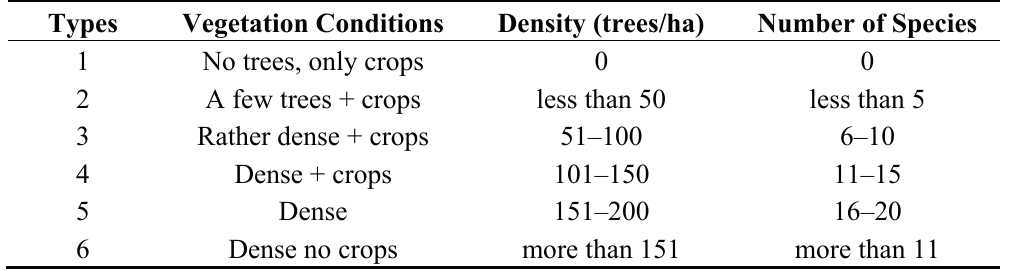
Table 4. Land classification based on tree density and number of species. Source: LATIN (2011) [37].